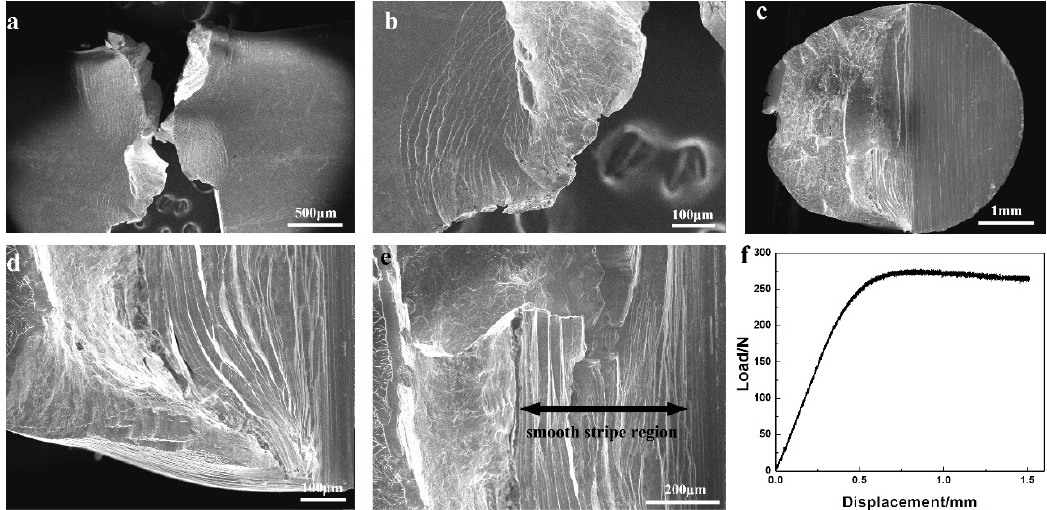
Figure 5. Appearance of a Vitreloy-1 MG rod with a size of φ 2 after 3-point bending. ( a – b ) Side surface appearance. ( d – f ) Fracture surface appearance. ( f ) Loading curve.